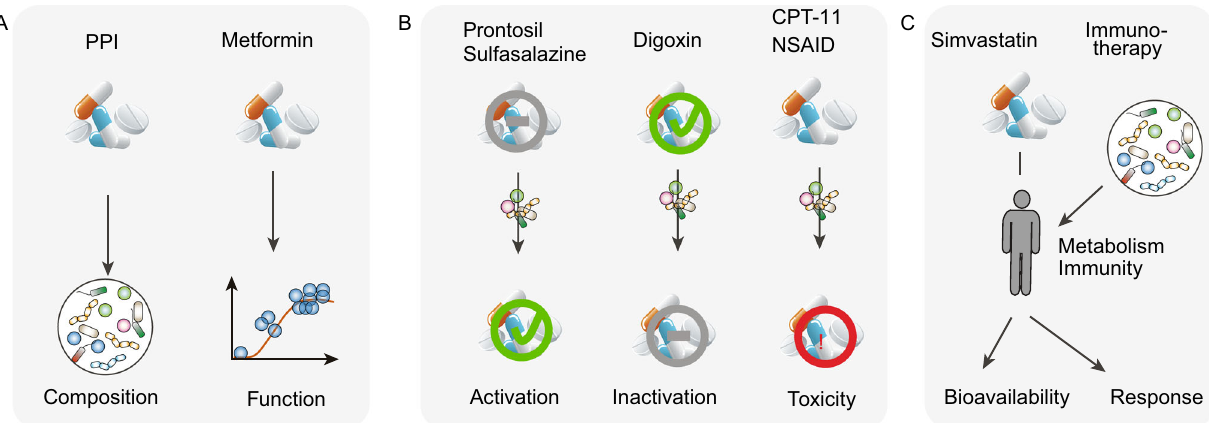
Figure 2. Drug-microbe effects. (A) Impact of drugs on the gut microbiome: drugs can perturb microbial composition and function. (B) Direct effect of gut microbiome on drug ef fi cacy and toxicity: microbial transformation can activate or inactivate drugs, or induce drug toxicity to the host. (C) Indirect effect of gut microbiome on drug response: the gut microbiome can in fl uence drug bioavailability and drug response via its interaction with host immune and metabolic systems. Speci fi c examples illustrate each